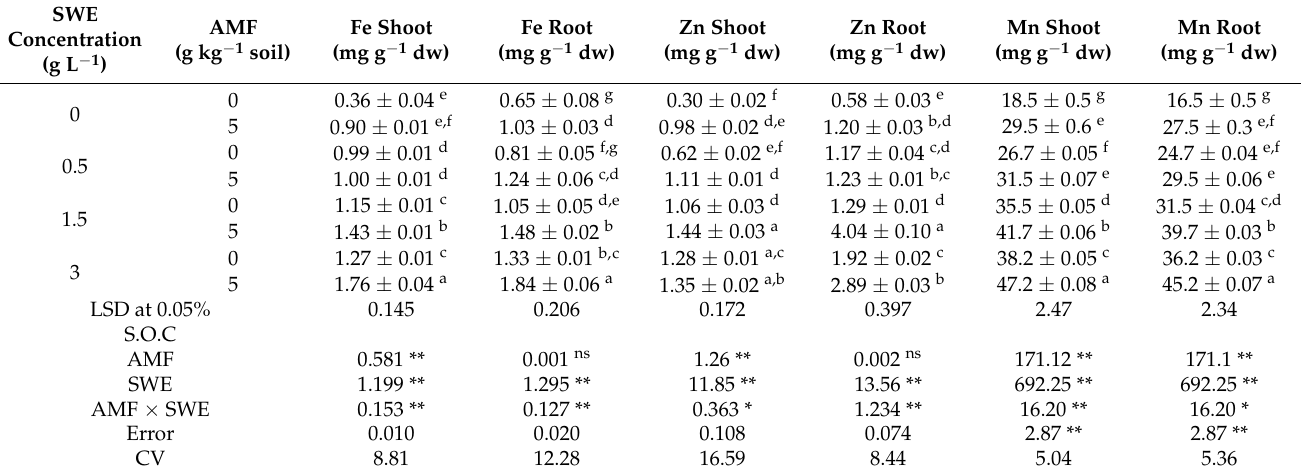
Table 5. The microminerals content in lettuce plants treated with arbuscular mycorrhiza fungi (AMF) and seaweed extract (SWE).